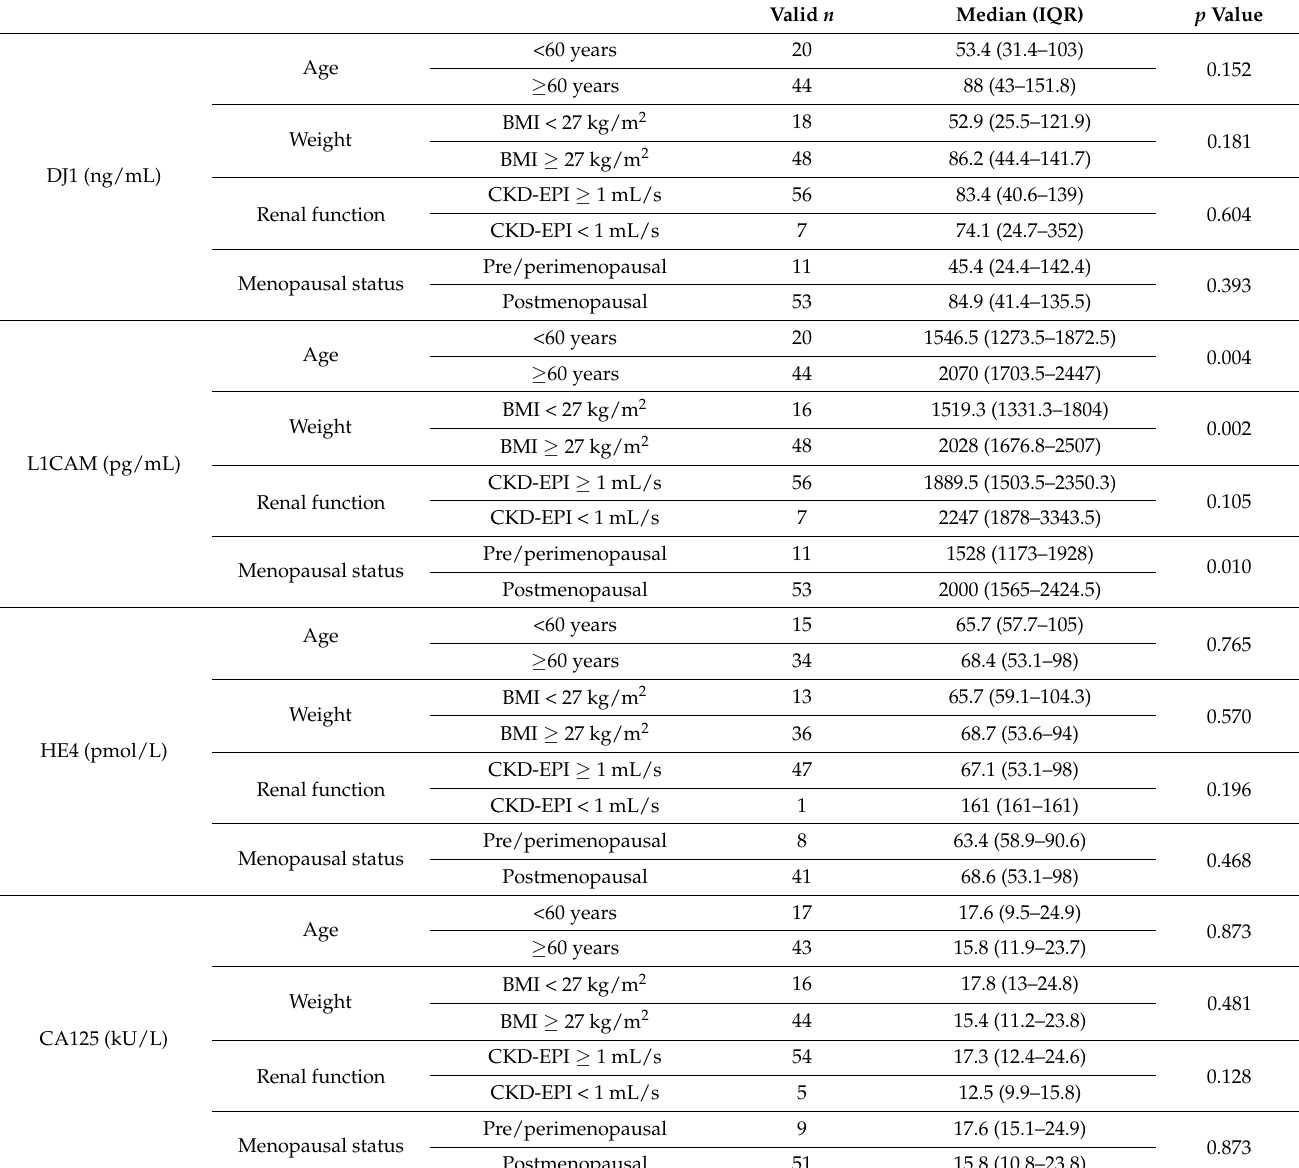
Table 5. DJ1, L1CAM, HE4 and CA125 preoperative serum levels according to age, weight, renal function and menopausal